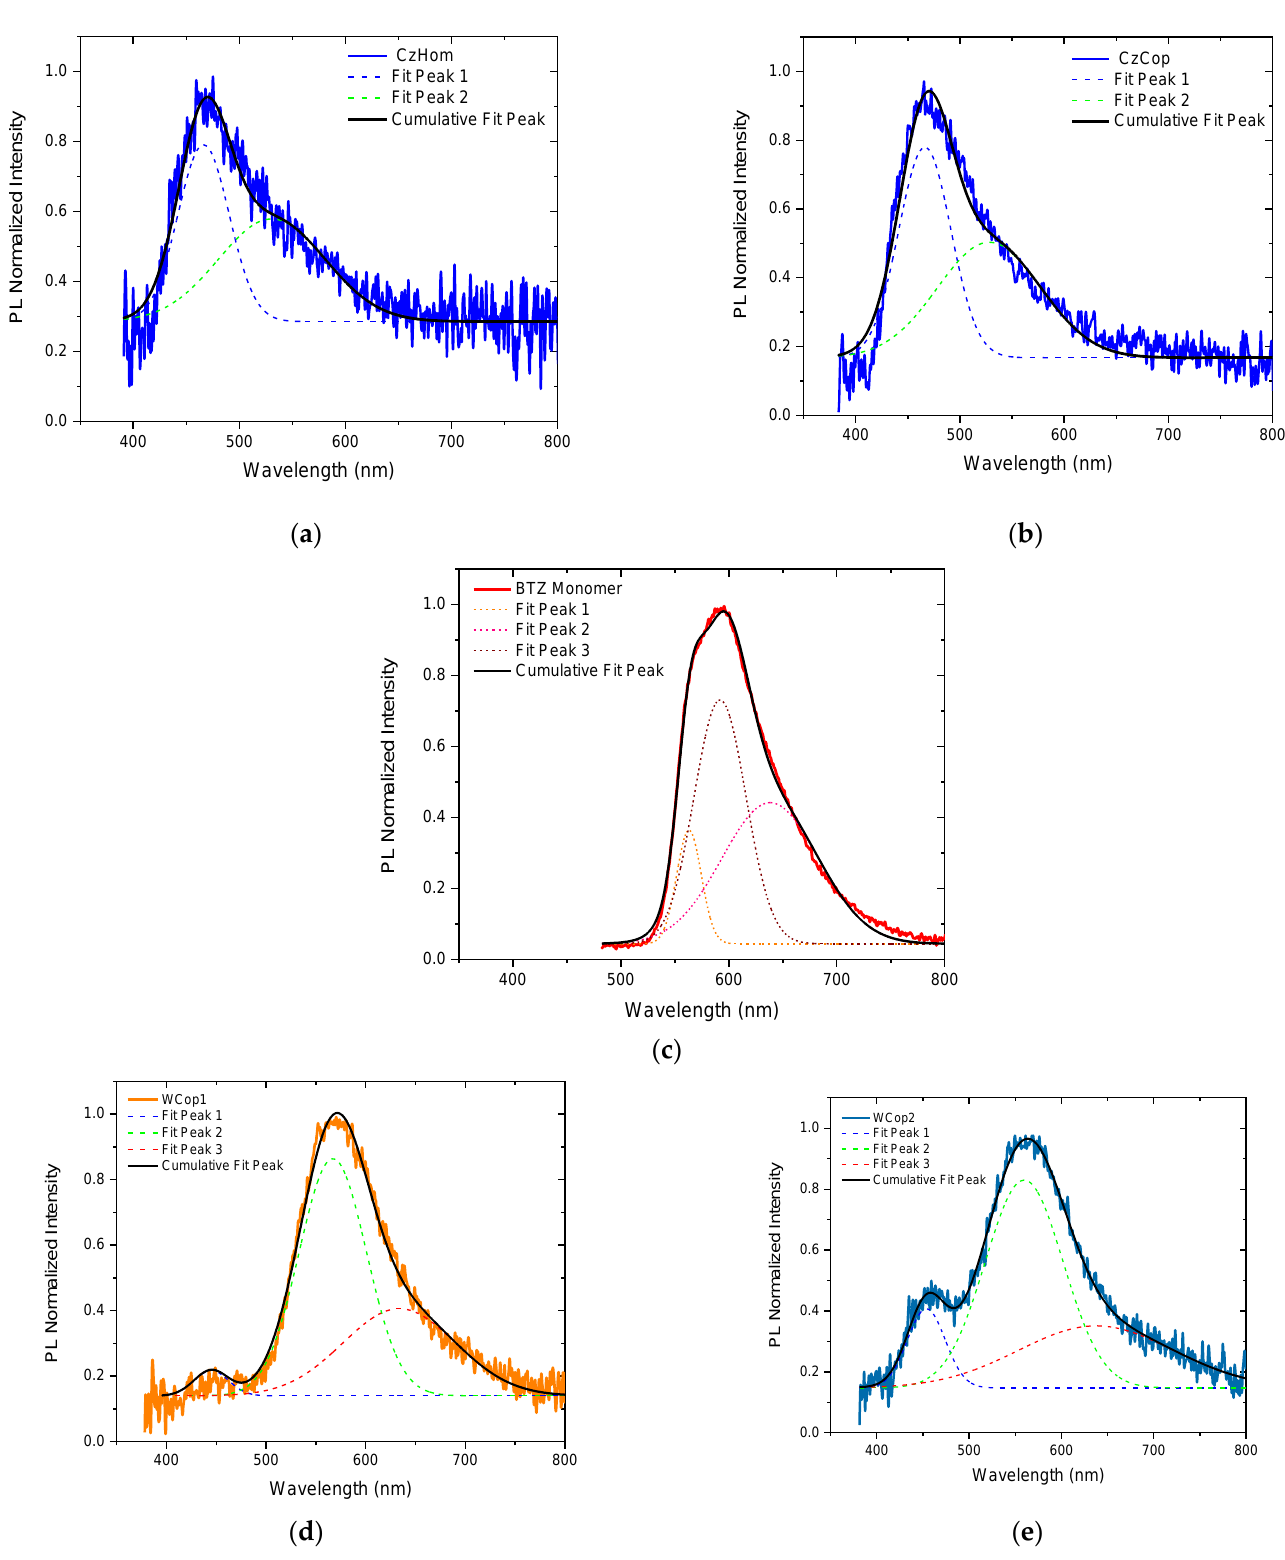
Figure 6. Deconvoluted normalized PL spectra of ( a ) CzHom, ( b ) CzCop, ( c ) BTZ monomer, ( d ) WCop1 and ( e ) WCop2 films.